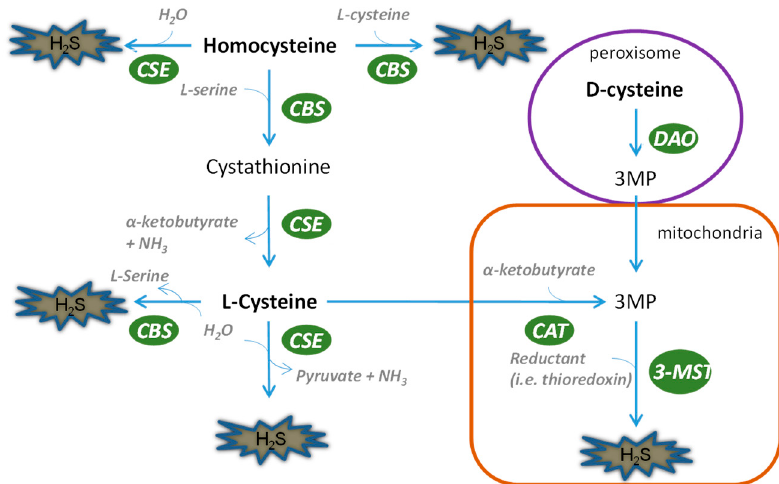
Figure 1. Biosynthesis of H 2 S in the kidney. The biological production of H 2 S in the kidney is mediated by four pathways. CSE and CBS can use L -cysteine and homocysteine as substrates to generate H 2 S in cytosol, while they can translocate into mitochondria in hypoxic states. L -cysteine and D -cysteine have to be catalyzed into 3MP before they can be utilized by 3-MST for the production of H 2 S. 3-MST mediates H 2 S production, mainly in mitochondria.